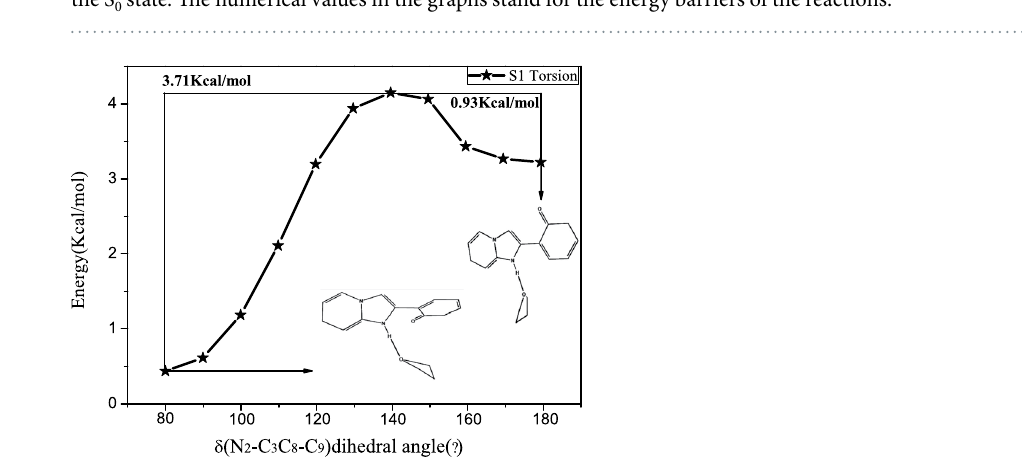
Figure 12. Constructed the potential energy curves of the HPIP: ( a ) the energies of different versus the O 1 -H 1 bond lengths in the S 0 state, ( b ) the energies of different structures versus the dihedral angles δ (N 2 -C 3 C 8 -C 9 ) in the S 0 state. The numerical values in the graphs stand for the energy barriers of the reactions.